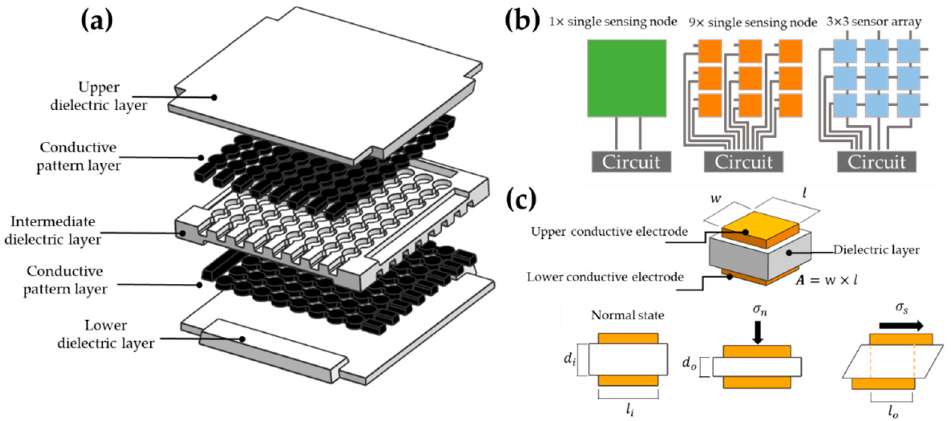
Figure 2. ( a ) Schematic illustration of the proposed all ‐ elastomeric skin ‐ like pressure sensor array; ( b ) conceptual topologies diagrams of array sensor; ( c ) principle of operation to measure normal and shear stress.